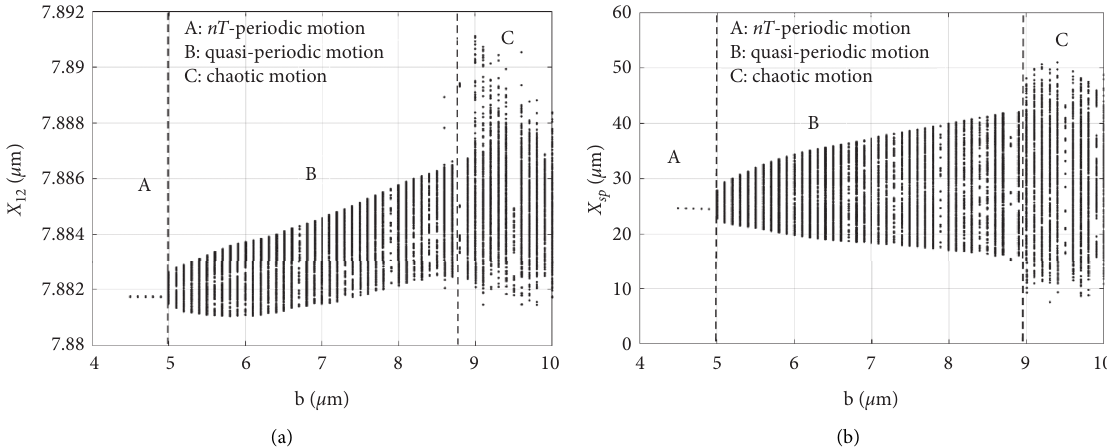
Figure 10: Bifurcation diagram of system with varying gear backlash. (a) Relative displacement of spline joint pair, (b) relative displacement of external gear meshing